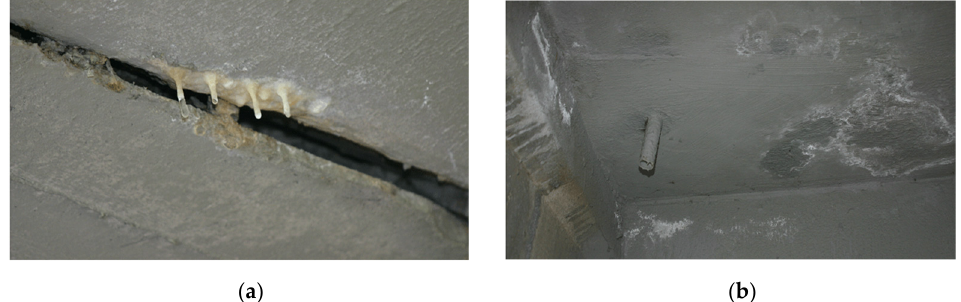
Figure 1. Types of water-leakage on bridge deck; ( a ) joint leakage, ( b ) slab leakage.